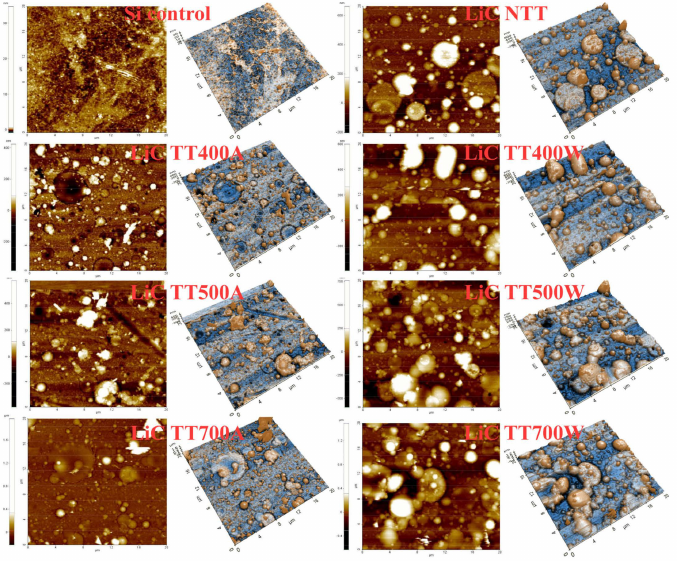
Figure 8. The 2D (classical view mode) and 3D (enhanced color view mode) AFM images of control Si, NTT LiC coatings and of those subjected to post-deposition thermal treatments (at different temperatures), in air (A–left columns) and water-vapor (W–right columns) ambient.